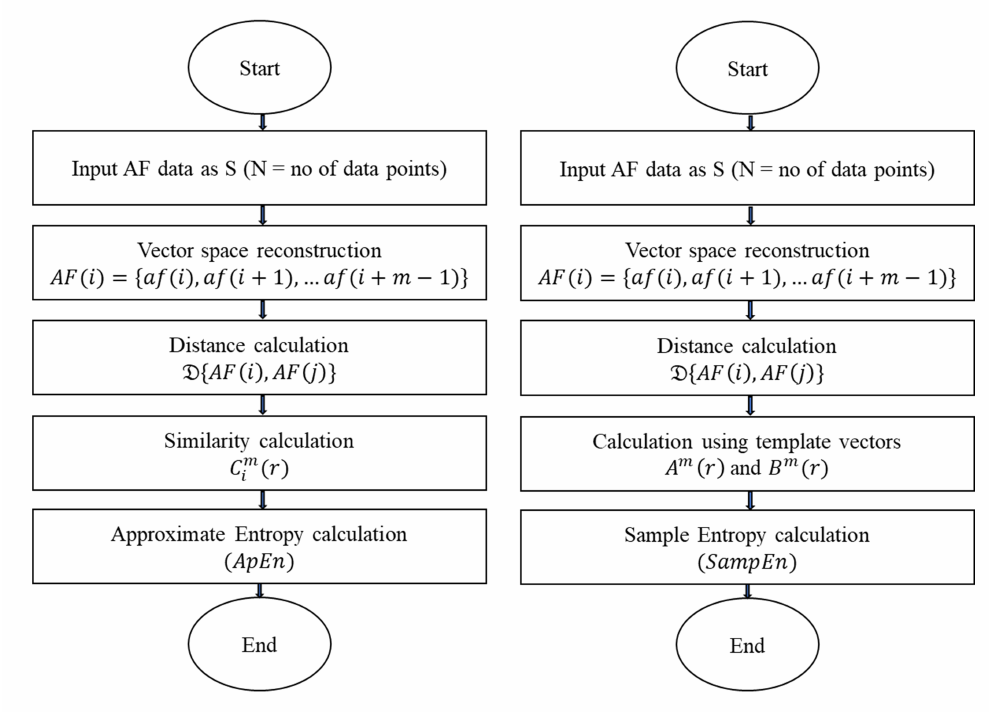
Figure 5. Details of the algorithms to compute Approximate Entropy ( ApEn ) and Sample Entropy ( SampEn ) on AF